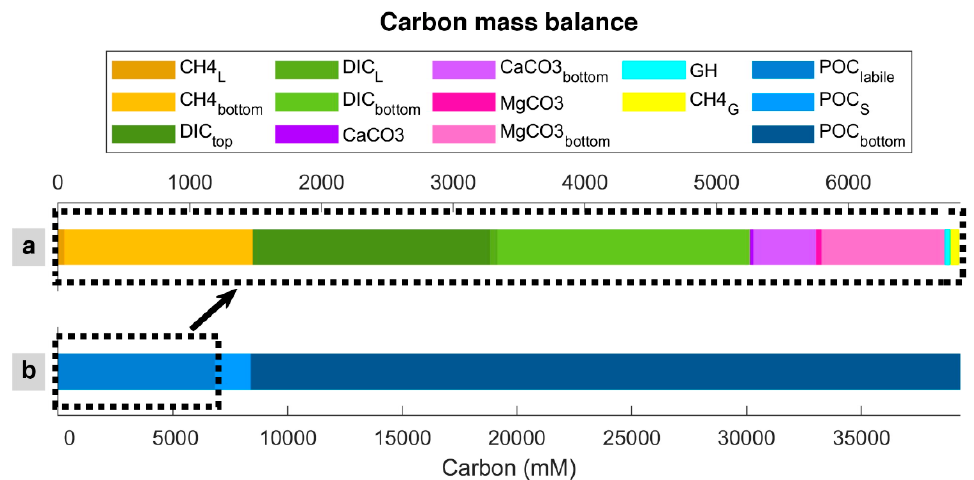
Figure 5. Carbon mass balance calculation in the last time step of the model. ( a ) represents the in situ carbon sinks, while ( b ) is the total carbon entered the modeled column. Subscript “S”, “L”, and “G” represents concentrations in the solid phase, dissolved in pore water (liquid), and free gas